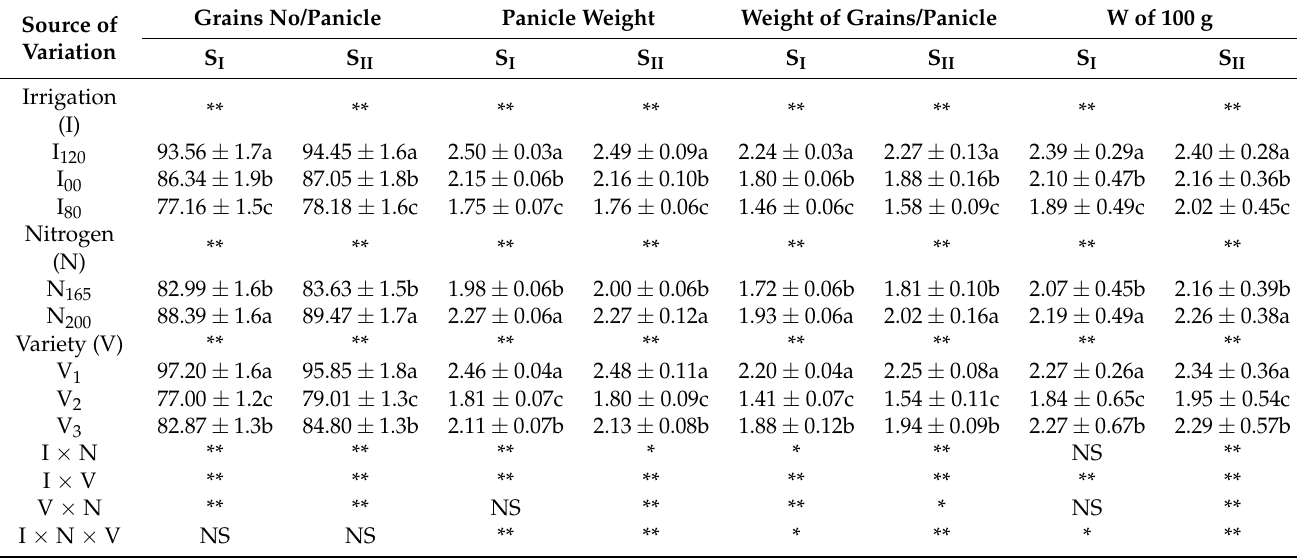
Table 5. Effect of deficit irrigation, nitrogen fertilizer varieties, and their interaction on yield component of rice in 2017 (S I ) and 2018 (S II ) seasons.